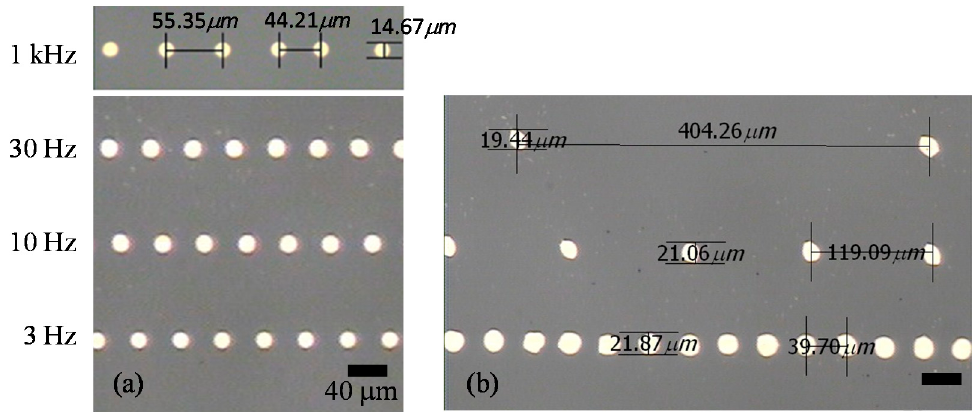
Figure 4. Printed drops of Ag ink with various pulsation frequencies of 1, 10, 30, and 1000 Hz for ( a ) overdamped system (Nozzle A; Γ = 2.0) and ( b ) underdamped system (Nozzle B; Γ = 0.8) at the minimum pulse voltages of jetting of 150 V and 300 V, respectively. The two nozzles have the same diameter d n of 30 μ m and the same natural frequency f c of 224 Hz, while they have different damping ratios.